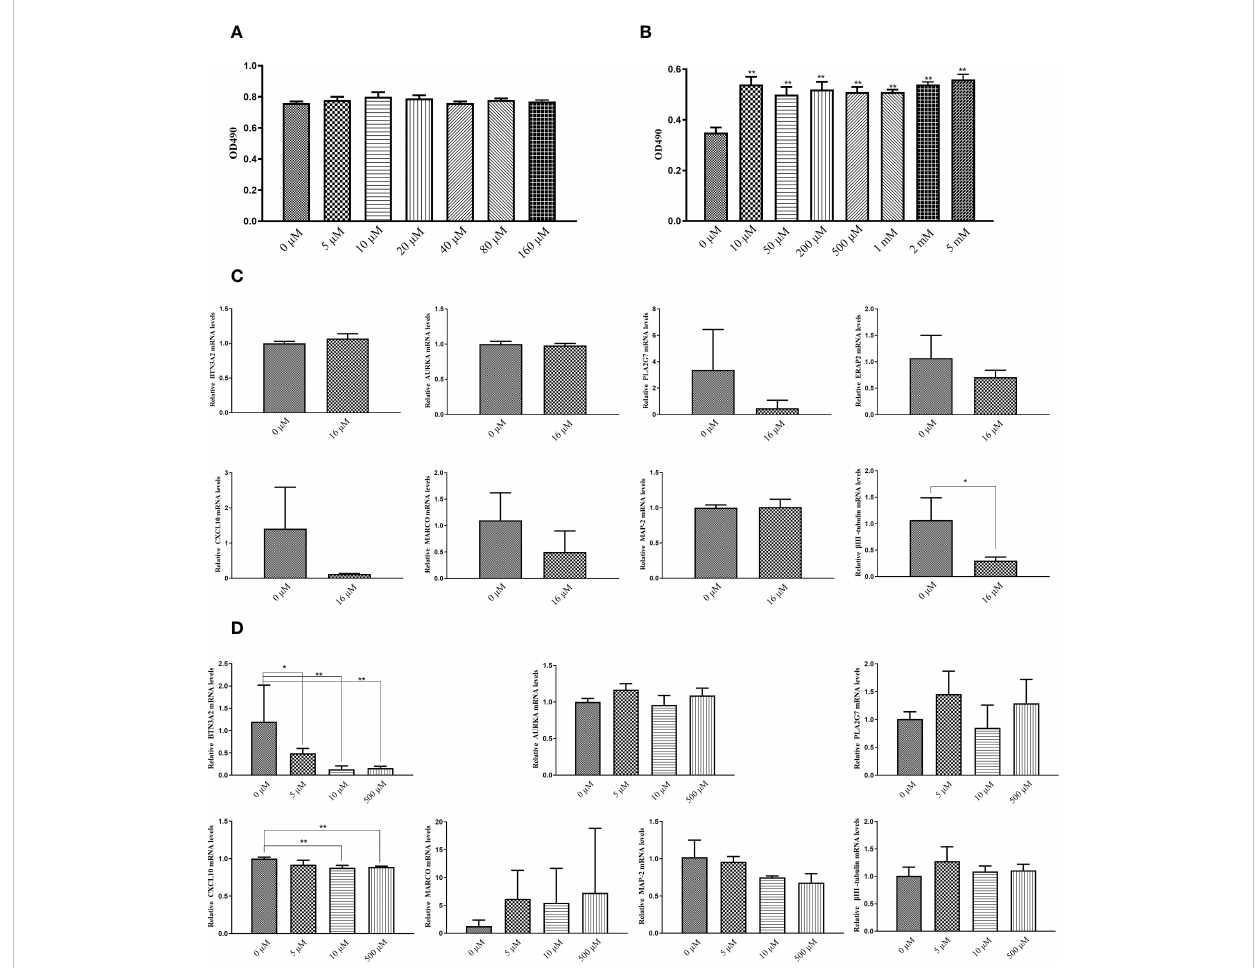
FIGURE 10 In vitro validation of the targets using MTT assay and qPCR. (A) MTT assay to measure cell viability in PC12 cells after treatment with AU at 0 to 160 m M concentrations (In comparison with the control group, *P < 0.05, and ** P < 0.01). (B) MTT assay to measure PC12 cell proliferation after treatment with AU at 0 to 5 mM concentrations (In comparison with the control group, *P < 0.05, and ** P < 0.01). (C) Quantitative analysis of BTN3A2, AURKA, PLA2G7, ERAP2, CXCL10, MARCO, MAP-2 , and b III-tubulin gene expression in HFLS cells by real-time PCR (In comparison between two groups, *P < 0.05, and ** P < 0.01). (D) Quantitative analysis of BTN3A2, AURKA, PLA2G7, CXCL10, MARCO, MAP-2 , and b III-tubulin gene expression in PC12 cells by real-time PCR (In comparison between two groups, *P < 0.05, and ** P <